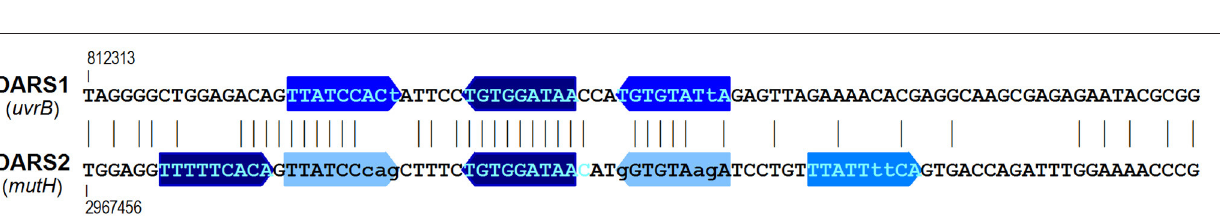
FIGURE 15 | The DARSs (DnaA reactivating sequences). The coordinates given above and below the DARS sequences (Fujimitsu et al., 2009) are from E. coli K12 (acc.no. U00096.2). Vertical lines between the sequences indicate identical bases. See Figure 7 for color code for the